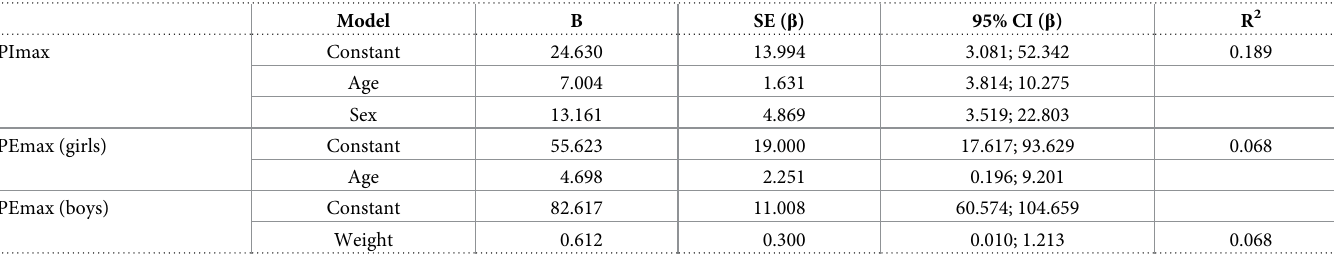
Table 3. Prediction equations for PImax and PEmax in both